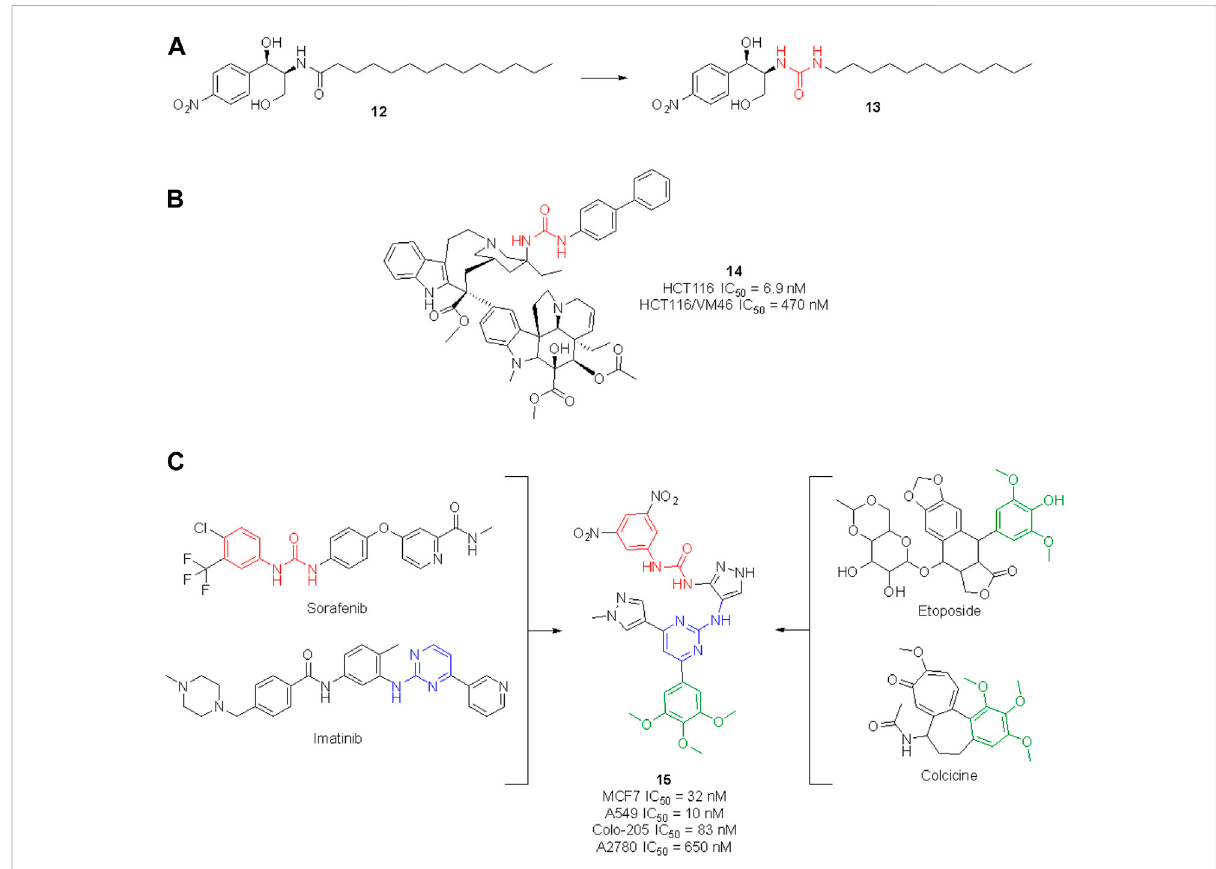
FIGURE 13 Developmentofnew urea-containingceramide analogs withanti-tumoractivity (A) ;structureofthevinblastineureidic derivative (B) ;designof a highly potent anticancer agent by merging the pharmacophoric elements of sorafenib, imatinib, colchicine and etoposide (C)